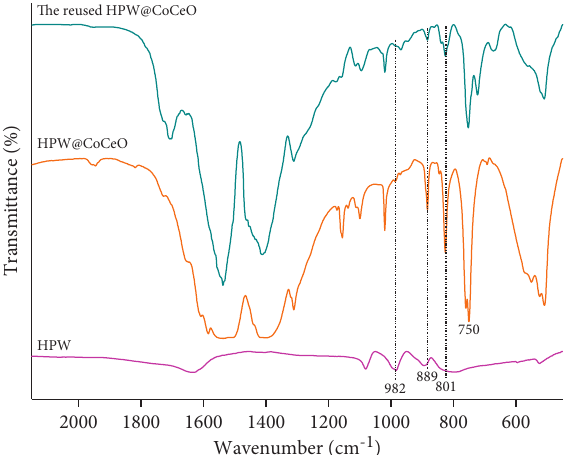
Figure 2: FTIR spectra of HPW, HPW@CoCeO, and the reused HPW@CoCeO